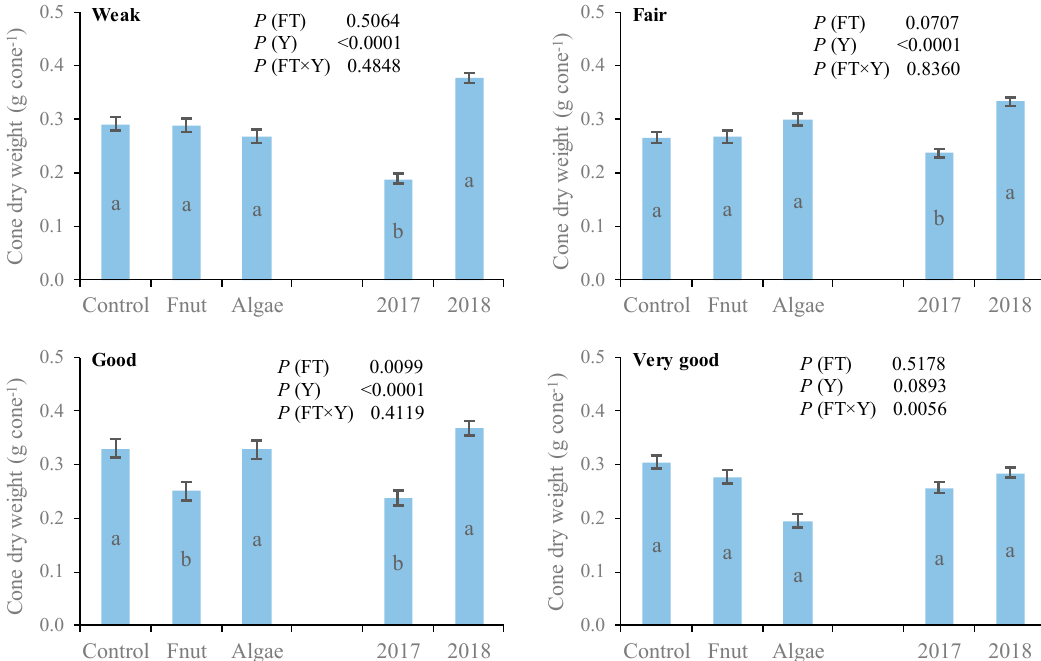
Figure 3. Dry weight of individual cones (average ± standard error) in the different plant vigour plots (Weak, Fair, Good and Very good) as a function of foliar treatment (Fnut, nutrient-rich foliar spray; Algae, algae-rich foliar spray; and Control) and year. Means followed by the same letter are not statistically different ( α = 0.05) by Tukey HSD (Foliar treatment) or t-Student (Year) tests.